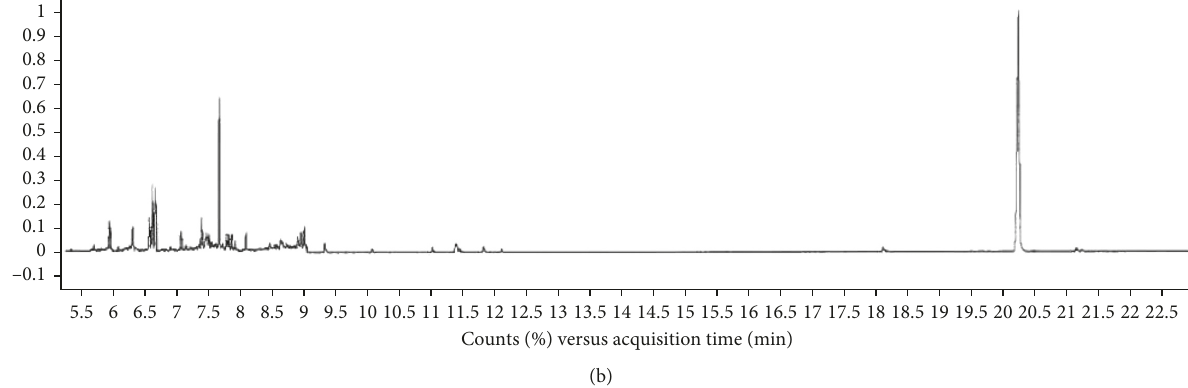
F IGURE 2: The selected-ion monitoring (SIM) obtained by Z-Sep QUE for meat samples under the selected parameters: (a) spike with 50ng/g of 16 PAHs and I.S. (1+2) Naphthalene+Naph_d8, (3) acenaphylene_d8, (4) acenaphthylene, (5) acenaphthene, (6) fluorine (7+8) phenanthrene +Phen_d10, (9) anthracene, (10+11) fluoranthene +Fluro_d10, (12 +13) pyrene+Pyr_d10, (14) benzo[a]anthracene, (15) chrysene, (16) benzo[b]fluoranthenem, (17) benzo[k]fluoranthene, (18+19) benzo[a]pyrene+B[a]P_d12, (20) indeno[1,2,3-cd]pyrene, (21) dibenz[a,h]anthracene, (22) benzo[g,h,i]perylene_d12, and (23) benzo[g,h,i]perylene. (b) Nonspike meat